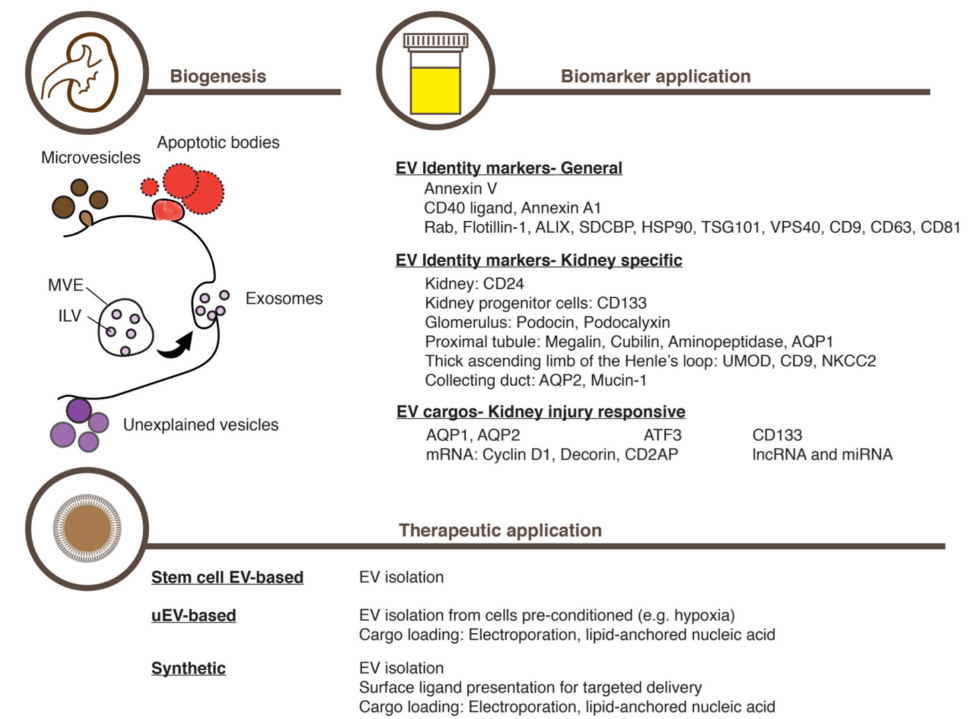
Figure 1. Generated by multiple mechanisms, extracellular vesicles (EVs) carry a set of macro- molecules that reflect the normal and the pathological (e.g., acute kidney injury) states of the produc- ing cells. EVs can also be engineered to deliver therapeutically potent, bioactive macromolecules to desired target cells. MVE, multivesicular endosome. ILV, intralumenal vesicle, uEV, urinary